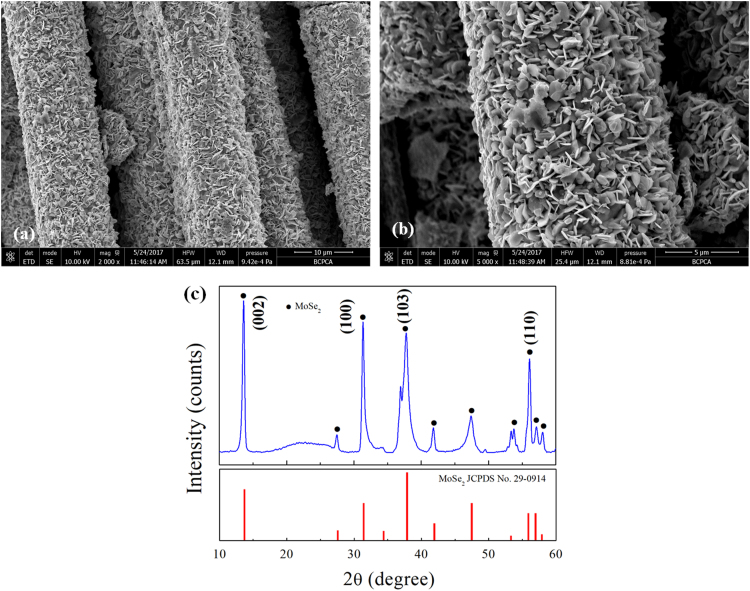
Typical low- and high- magnification SEM images (a, b) and the corresponding XRD pattern (c) of the C fibers@MoSe2 NPCSC catalyst after being applied in the photodegradation of K2Cr2O7 solution under SSI for 120 min.